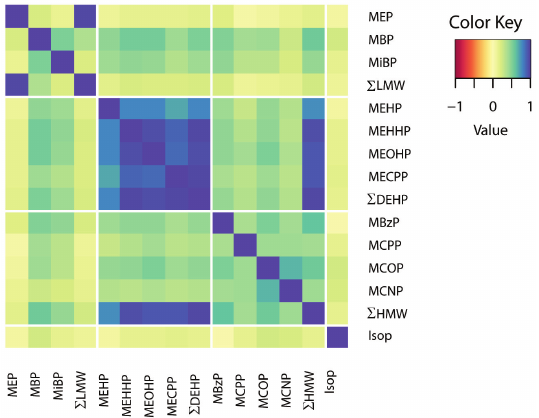
Figure 2. Correlation matrix of concentrations between eleven phthalate metabolites and isoprostane averaged for two time points in early and late pregnancy. Each colored square represents Pearson’s correlation coefficient between different phthalate metabolites. The dark blue squares indicate strong positive correlations with correlation coefficients ranging from 0.5–1.